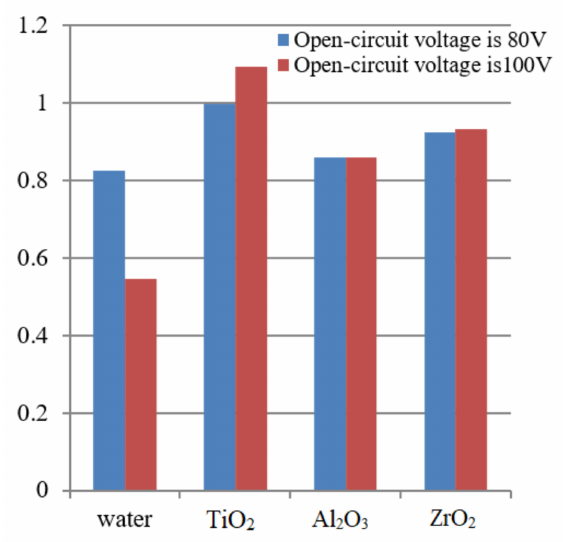
Figure 3. The images of the entrance and outlet of the micro holes machined in different dielectric.